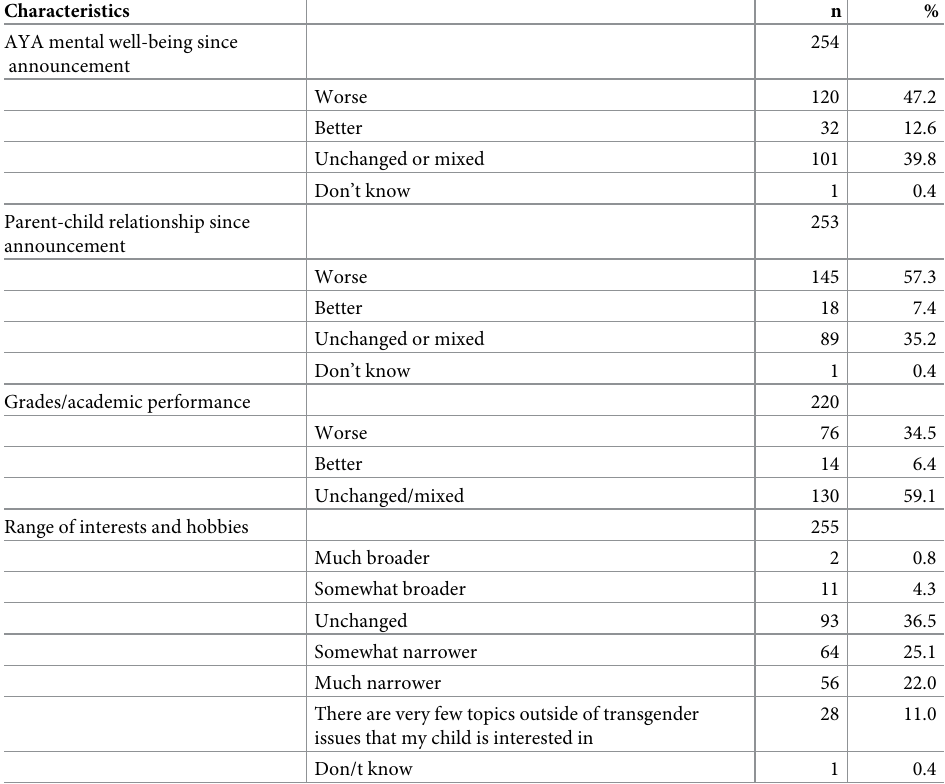
Table 8. Outcomes and